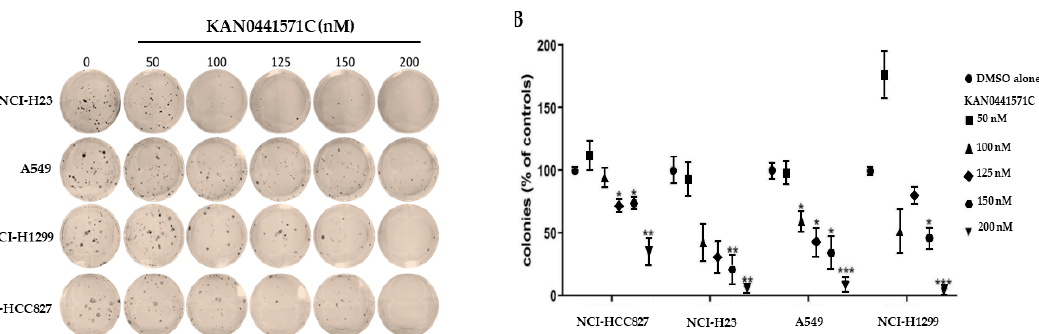
Figure 4. ( A ) Lung cancer cell lines (NCI-H23, A549, NCI-H1299, and NCI- HCC827) incubated